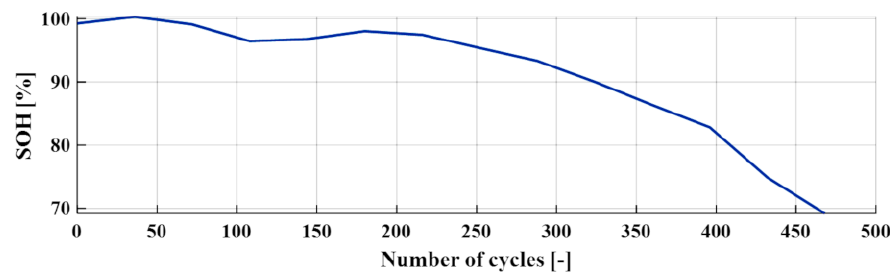
Figure 4. SOH of cylindrical LG MJI 18650 lithium-ion cell across the aging cycles.